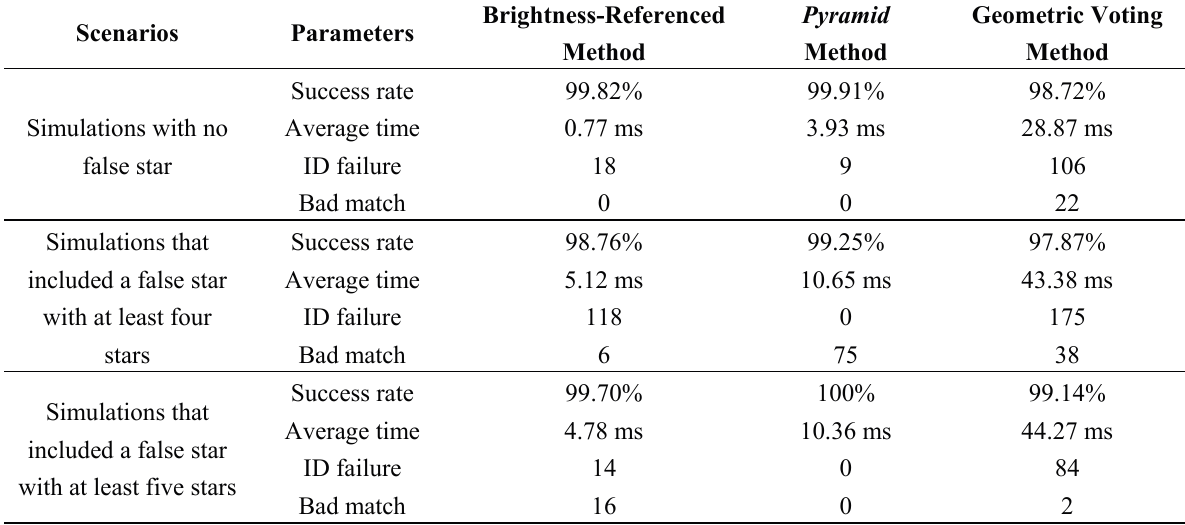
Table 3. Results of three methods with different